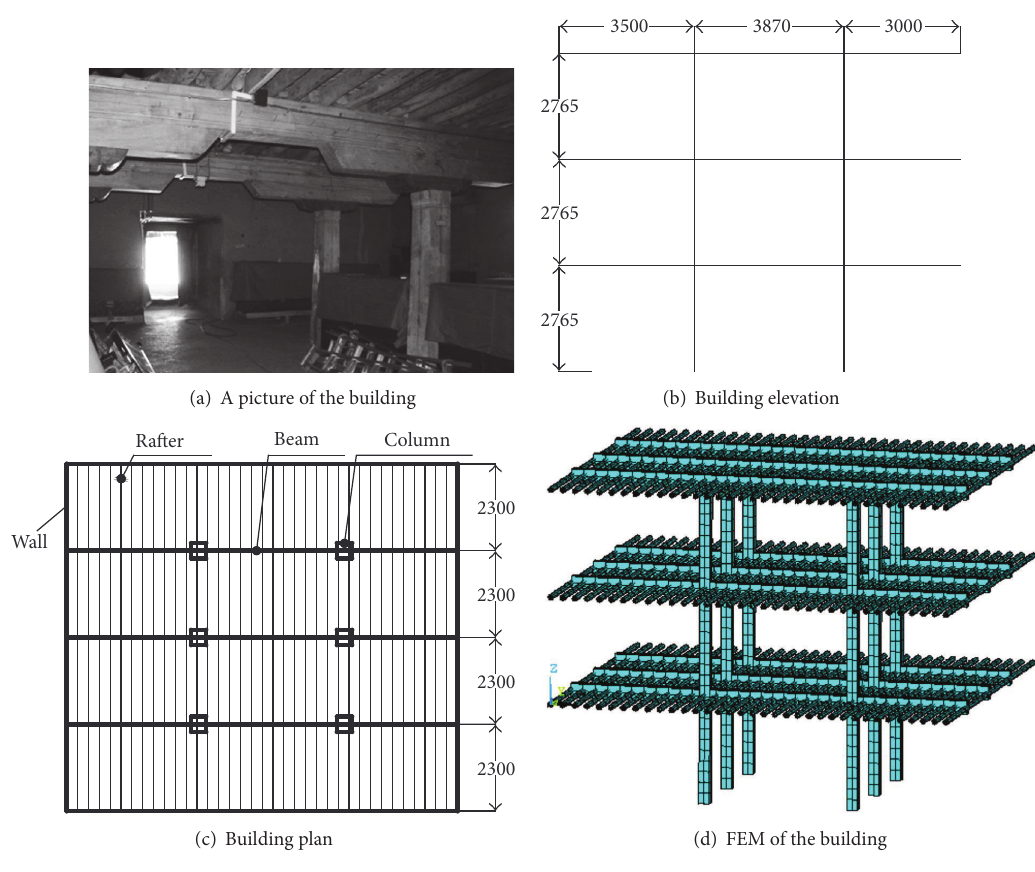
Figure 11: Information of the FEM.